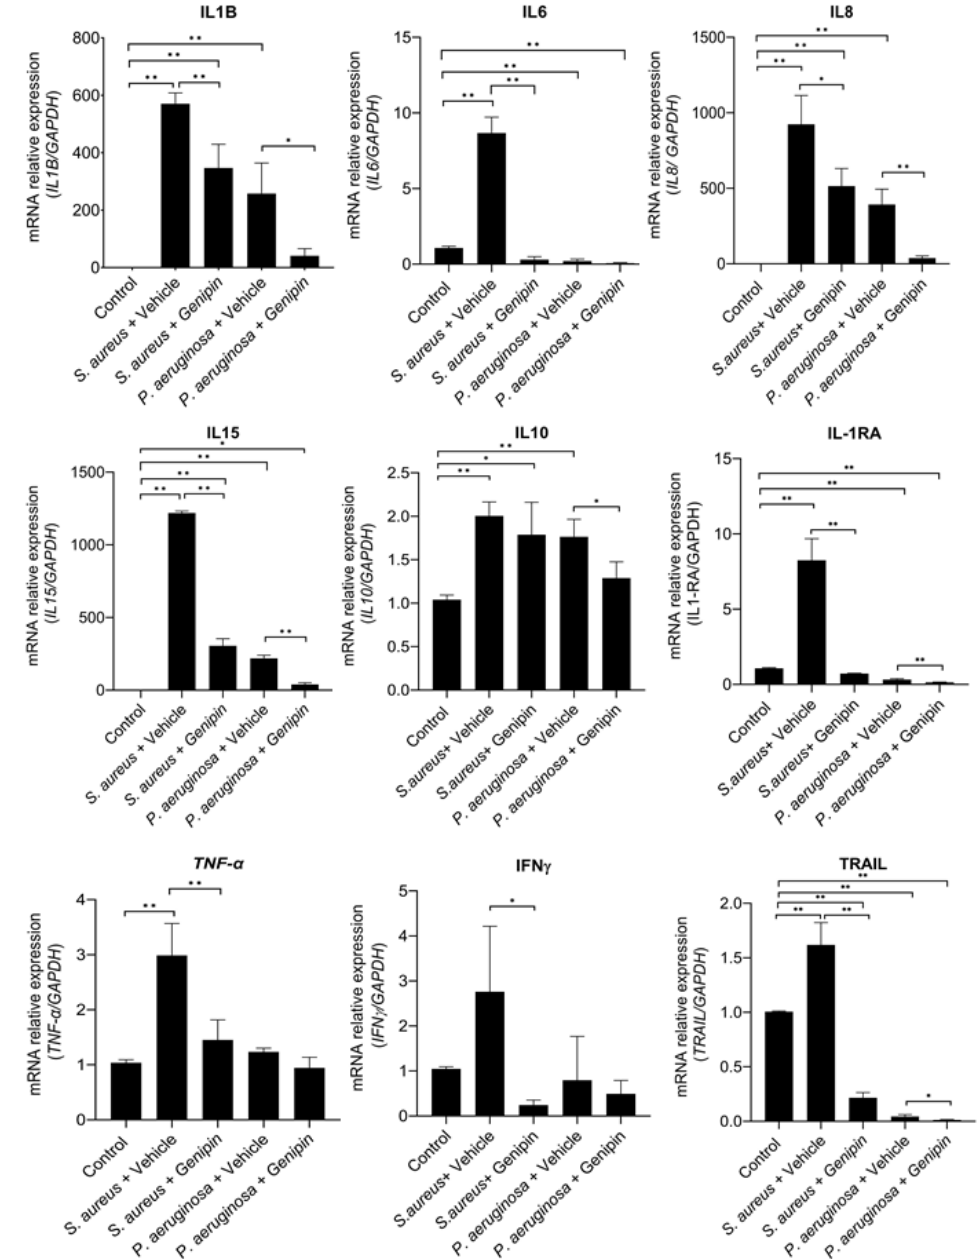
Figure 3. Genipin decreases the expression of inflammatory cytokines in the S. aureus and P. aeruginosa rabbit corneal keratitis model. Infected corneas were treated with either vehicle solution or genipin for 48 h. Total RNA was extracted and the mRNA expression levels of interleukin 1B(IL1B), interleukin 6 (IL6), interleukin 8 (IL8), interleukin 10 (IL10), interleukin 15 (IL15), interleukin 1 receptor antagonist (IL-1Ra), tumor necrosis factor- α (TNF- α ), interferon γ (IFN γ ) and tumor necrosis factor-related apoptosis-inducing ligand (TRAIL) were detected with qPCR. Data are average mRNA expression levels relative to GAPDH ± standard deviation. A total of five corneas were used for each experimental group and all samples were examined in triplicates. * p < 0.05, ** p < 0.01, comparing bracketed groups.